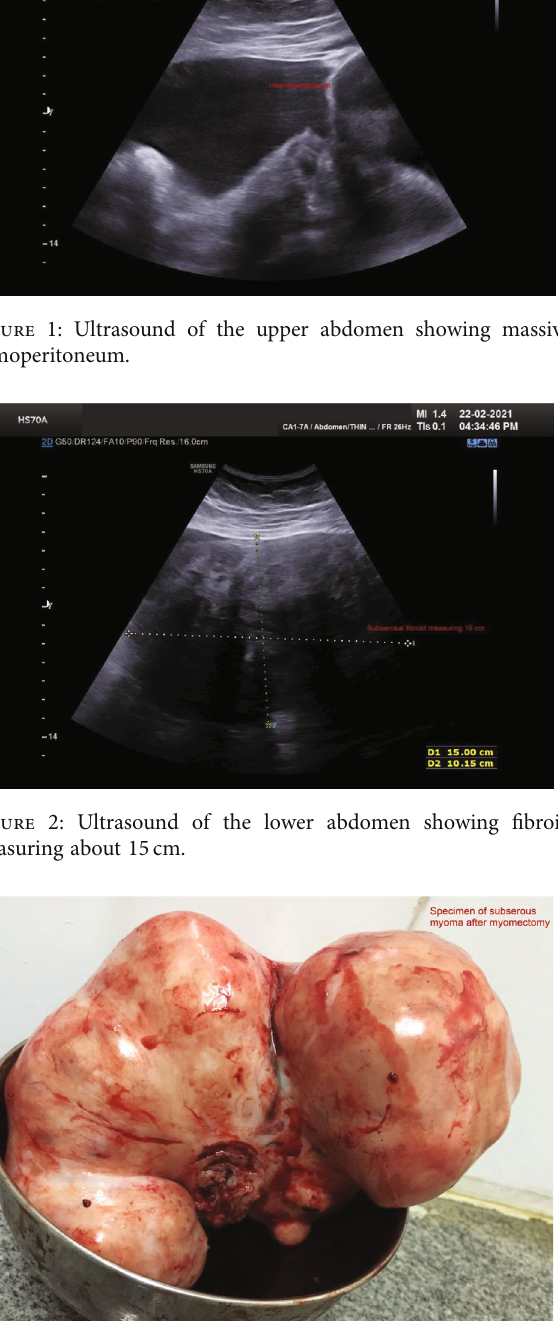
Figure 3: Subserous fi broid after